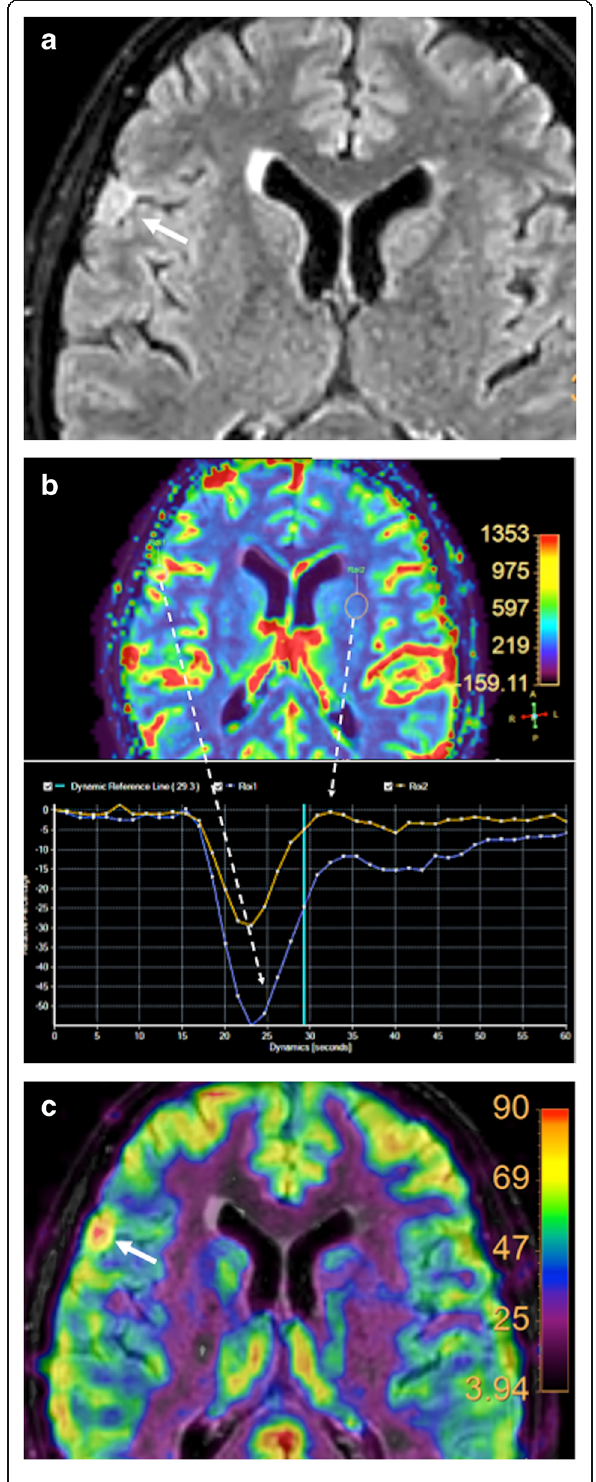
Fig. 19 Brain perfusion in a 55-year-old woman with a meningioma. a An axial fluid attenuation inversion recovery (FLAIR) image of the brain demonstrated a hyperintense extra-axial insular lesion (white arrow). Both ( b ) dynamic susceptibility contrast (DSC)-MRI and ( c ) arterial spin labelling (ASL) parametric maps demonstrated and increased perfusion in the mass. Comparison to normal brain parenchyma evdenced a higher decrease in MR signal intensity curves during the first-pass of the contrast bolus ( b , blue